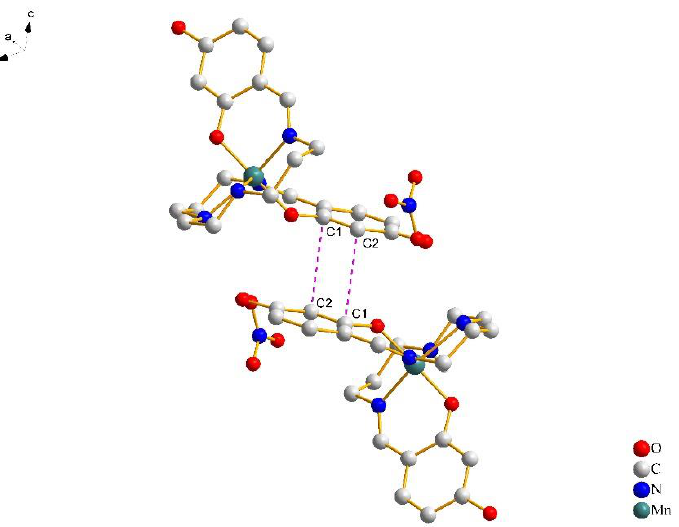
Figure 4. The details of π ··· π stacking interactions between phenolate rings of complex 1 at 100 K. Hydrogen atoms were omitted for clarity.